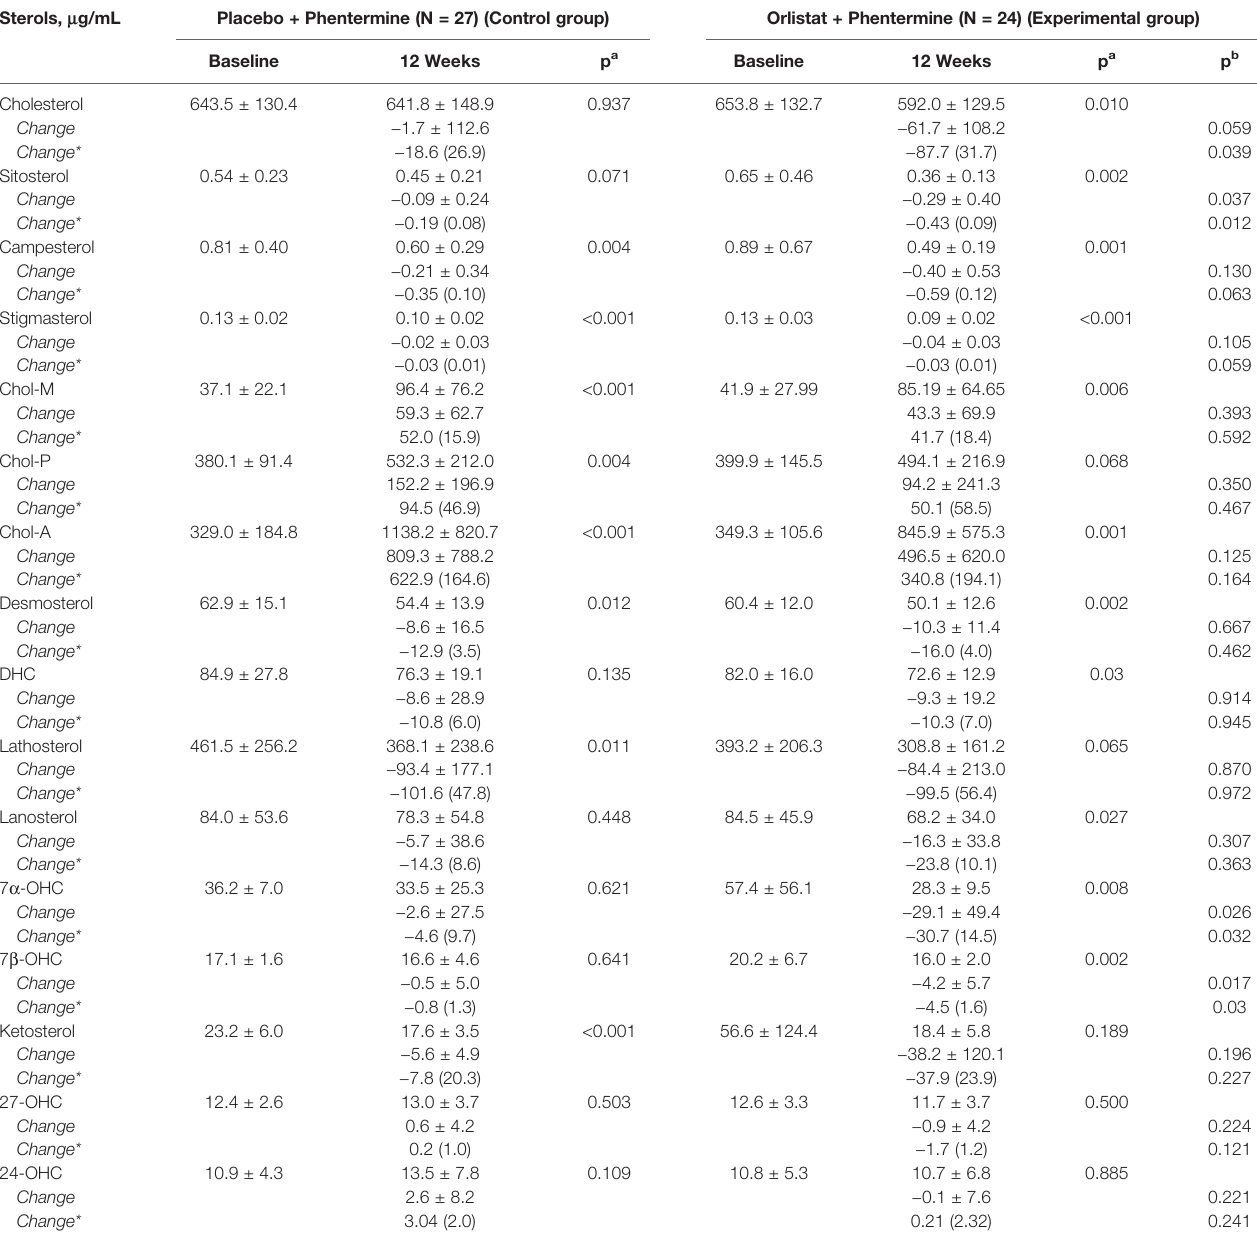
b Comparison of in-group changes; Calculated using the independent two sample t-test. Change * Comparison of in-group changes; Calculated using the analysis of covariance after adjusting for age, sex and baseline body